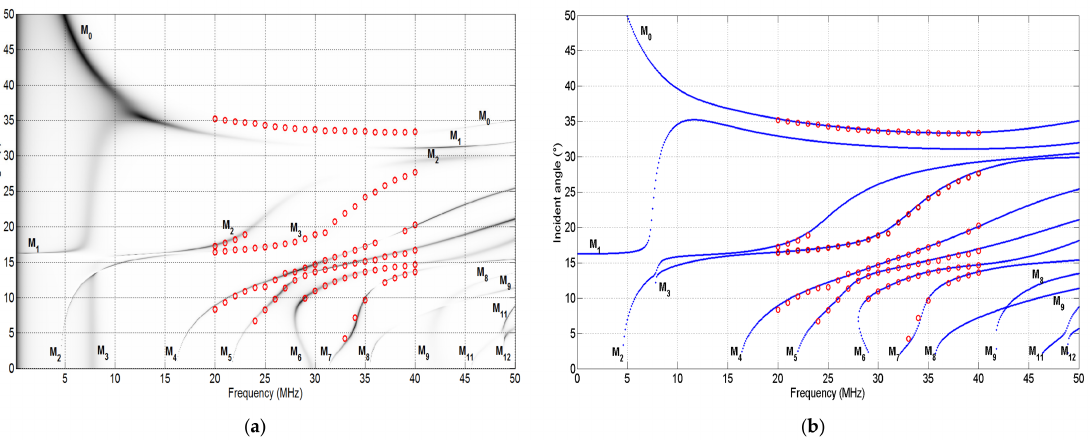
Figure 5. ( a ) Superimposition of the detected mode velocities (red circles), obtained with the classical V ( z ) transducer, with the modulus of the reflection coefficient; ( b ) corresponding superimposition with the dispersion